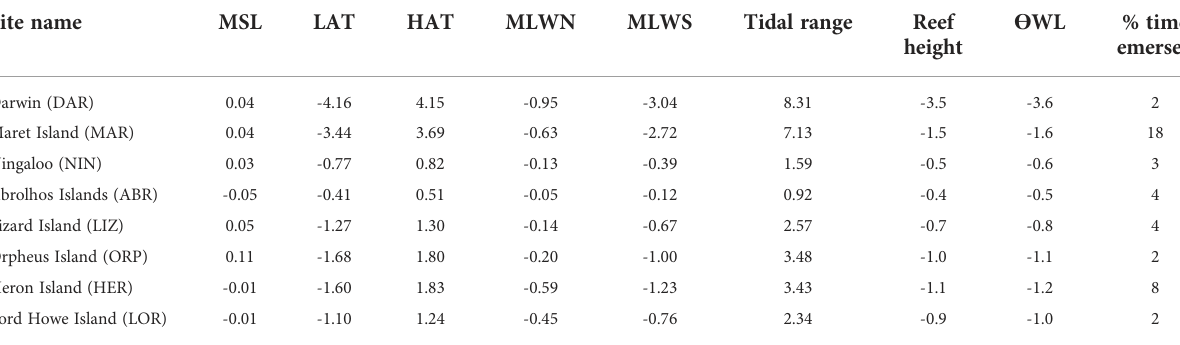
TABLE 3 Water level characteristics (m); mean sea level (MSL), lowest and highest astronomical tides (LAT/HAT), mean low water neaps (MLWN) and mean low water springs (MLWS) (from http://sealevelx.ems.uwa.edu.au), calculated tidal range, reef height estimate, emersion threshold ( Ɵ ) and percentage (%) time emersed for each study